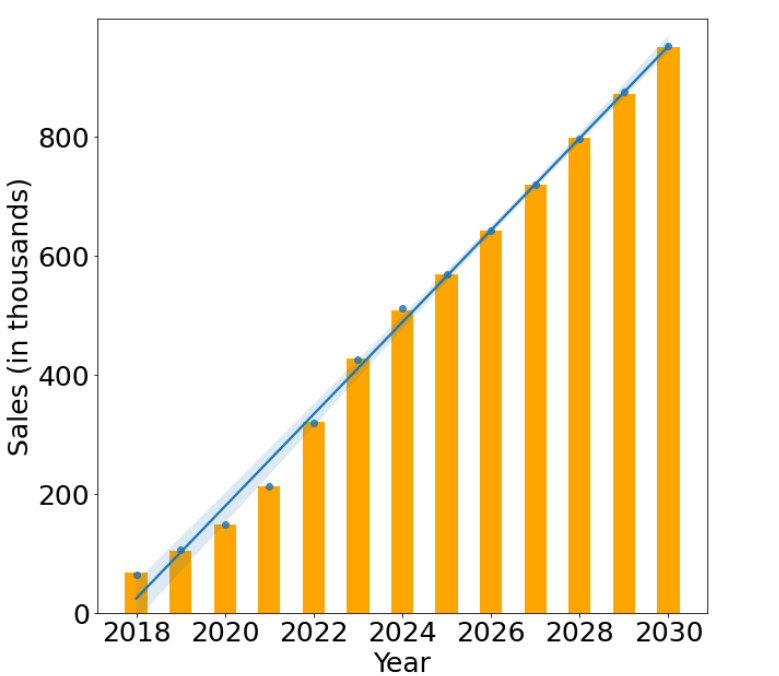
Figure 2. Prediction line statistics for autonomous car sales from 2018–2030